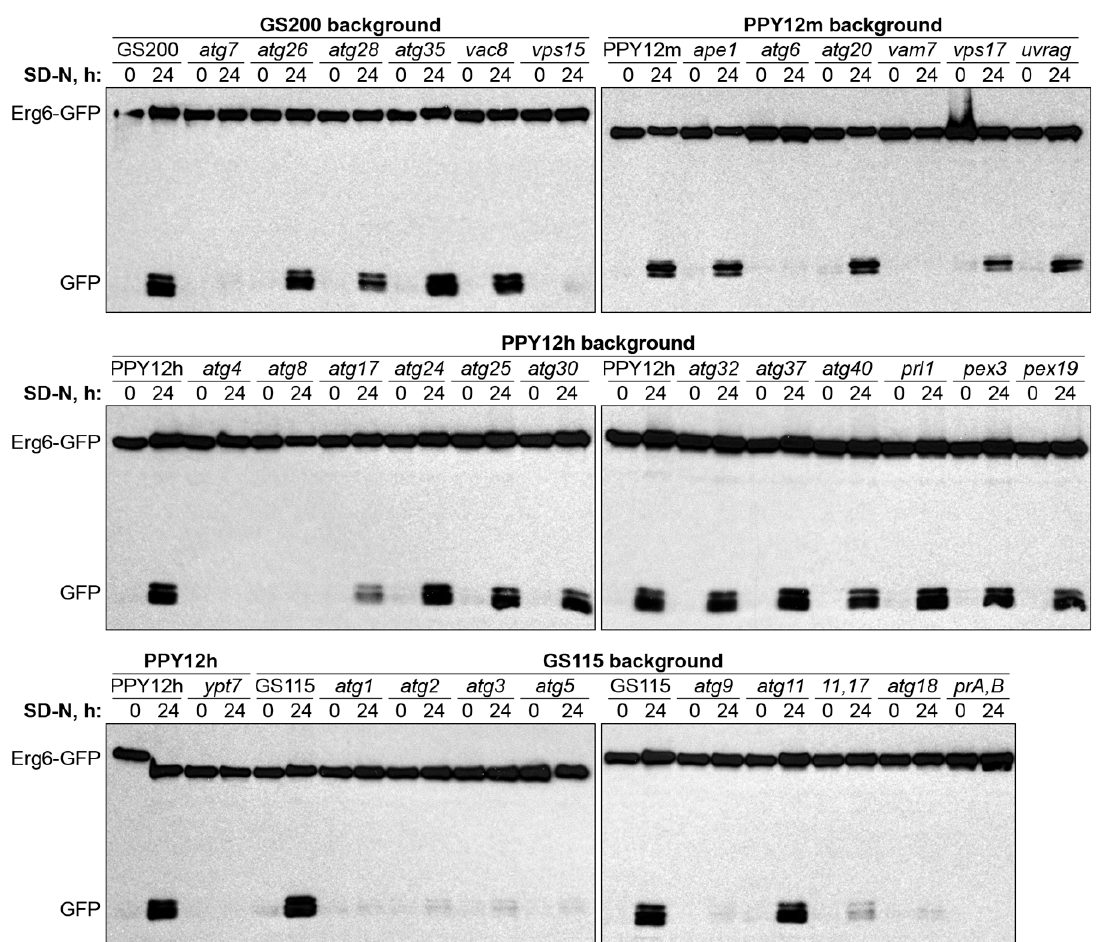
Figure 2. N-starvation lipophagy strictly depends on the core autophagic machinery (Atg1-Atg9, Atg18, and Vps15), vacuole fusion machinery (Vam7 and Ypt7), and vacuolar proteolysis (proteinases A and B). Cells were normalized in SD-N at OD 600 1, and an equal volume of culture (1 mL) was processed at both time-points for all strains to nullify the di ff erential growth (Erg6-GFP dilution) e ff ects in SD-N medium (loading control is not applicable). prA,B: Proteinases A and B-deficient mutant pep4 prb1